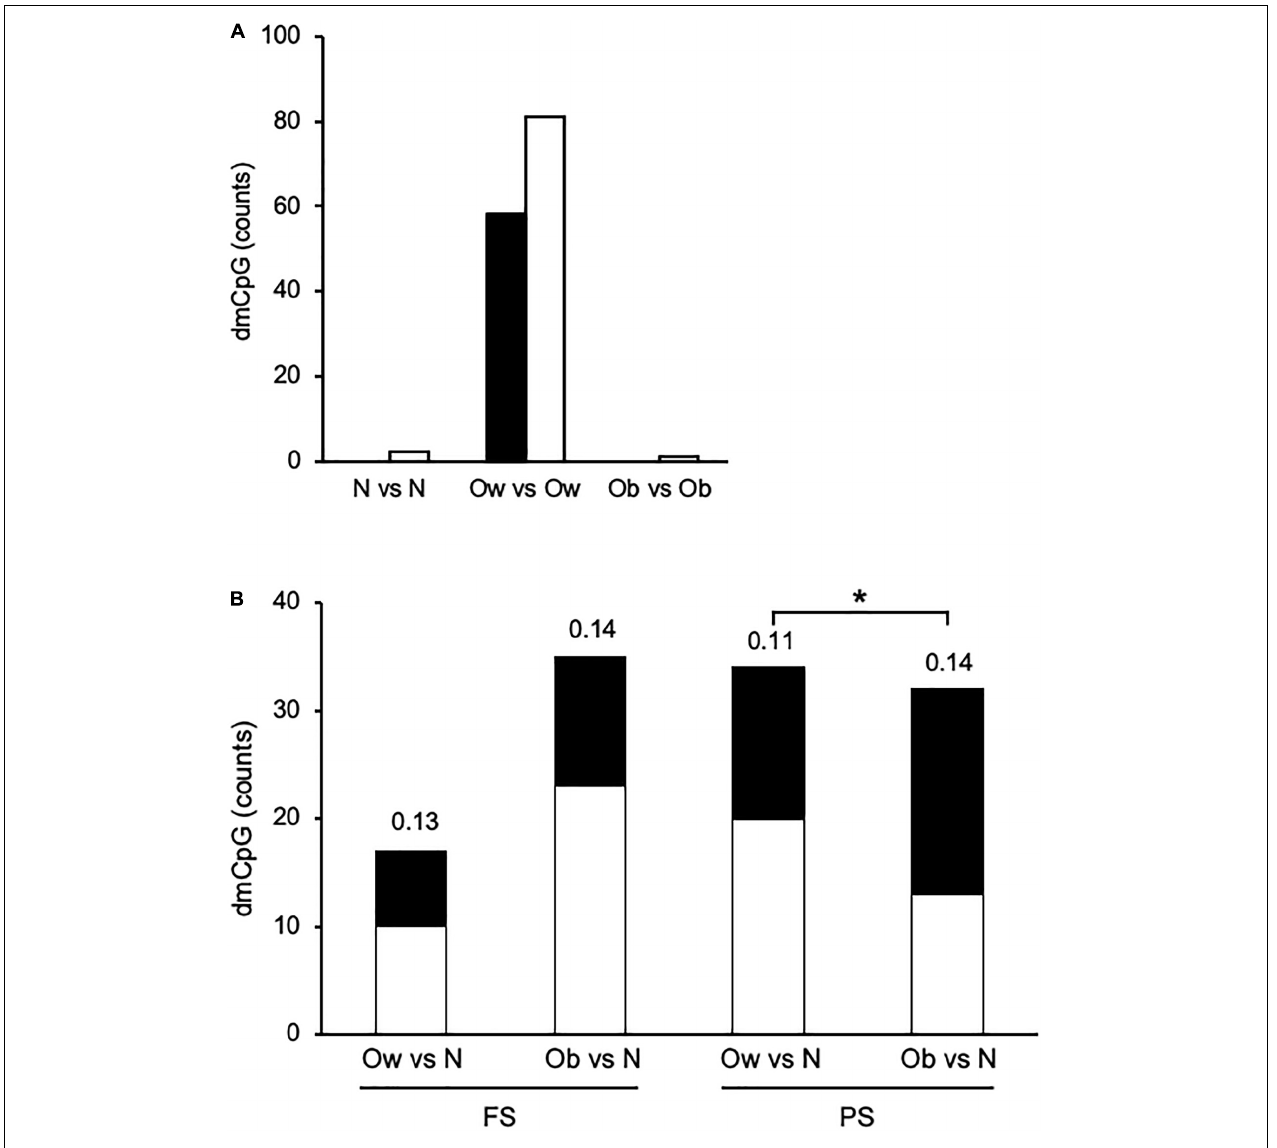
FIGURE 3 | Overview of prandial state-induced and BMI category-associated DNA methylation changes. (A) Within each BMI class in PS relative to FS. (B) Across BMI classes. Solid and open bars, hypermethylated and hypomethylated, respectively. The number above each bar indicates the average absolute (cid:49) β . N, Ow, and Ob, normoweight, overweight, and obese, respectively. *, p < 0.05. t -test between M